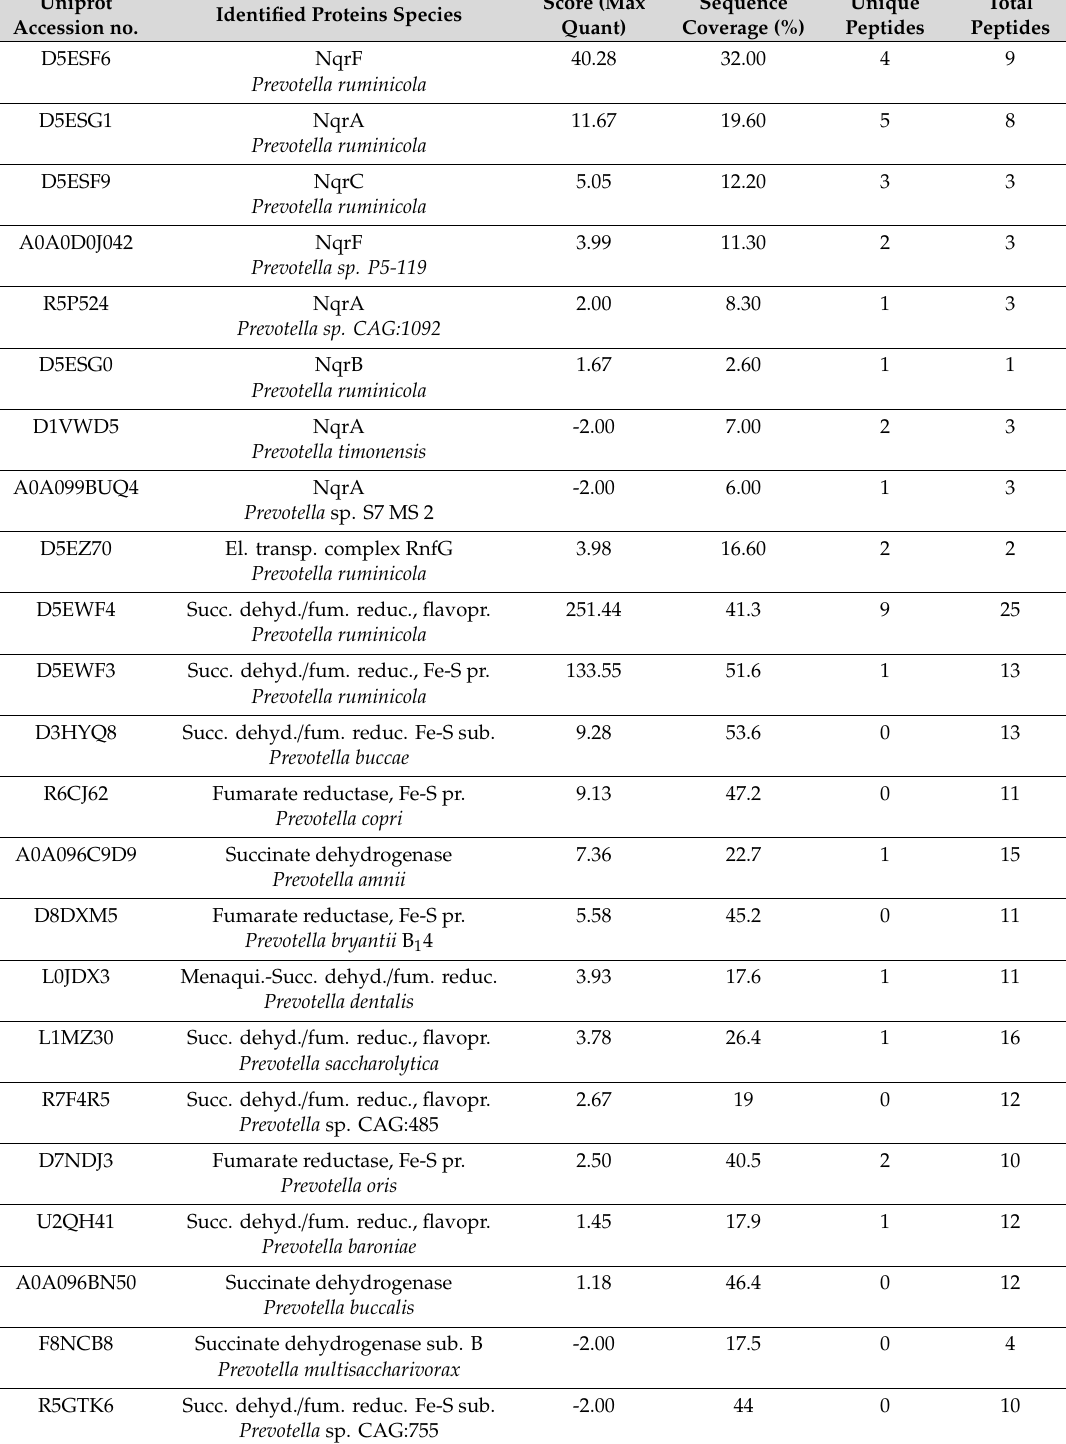
Table 1. Subunits of the Na + -translocating NADH:quinone reductase (NQR) and other respiratory enzymes produced by members of the Prevotellaceae family as identified by a metaproteomic survey of the rumen [17]. The entirety of identified proteins is listed in Table S1. Proteins belonging to the succinate dehydrogenase (succ.dehyd.) or fumarate reductase (fum. reduc.) were not identified unambiguously in all